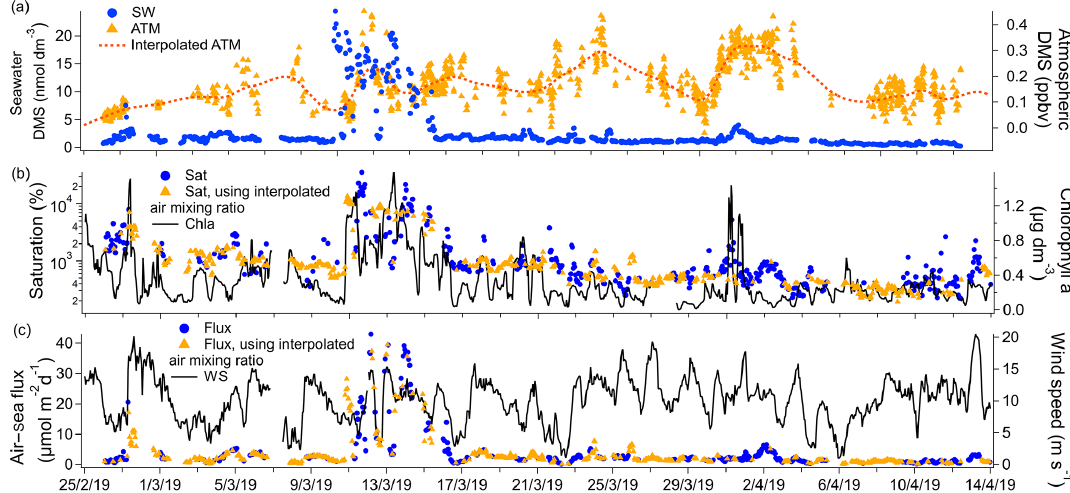
Figure 4. (a) Time series of DMS seawater (SW) concentrations as well as measured and interpolated marine boundary layer air mixing ratios (ATM and interpolated ATM). (b) Time series of DMS saturations determined using the measured air mixing ratio and interpolated air mixing ratio and time series of chlorophyll a . (c) Time series of air–sea DMS fluxes calculated using the measured air mixing ratio and interpolated air mixing ratio and time series of wind speed.